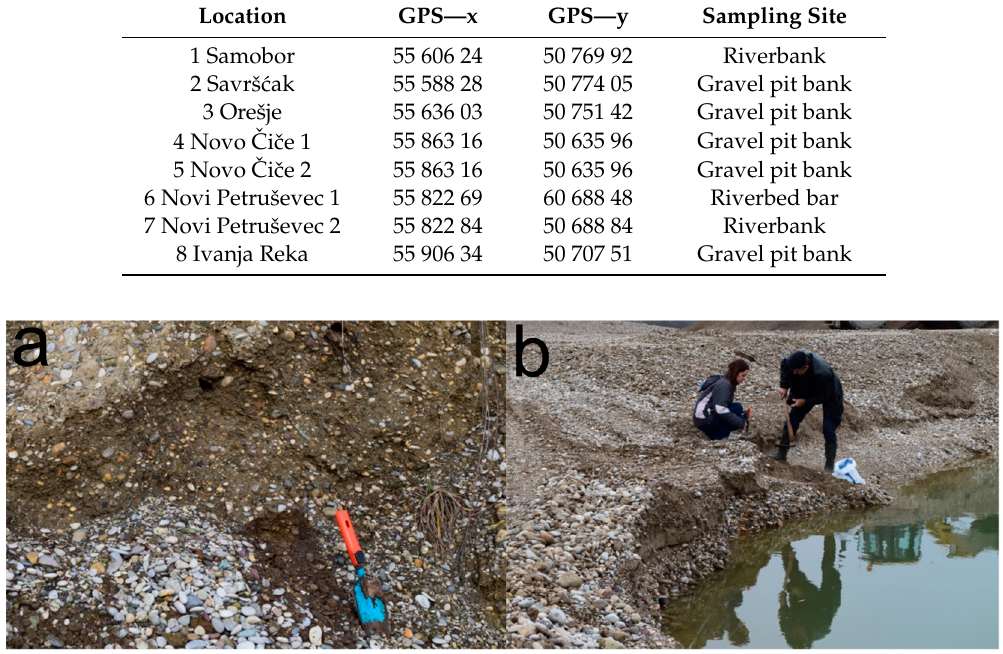
Figure 2. Sampling at gravel pit banks: ( a ) Ivanja Reka; ( b ) Savrš ć ak.